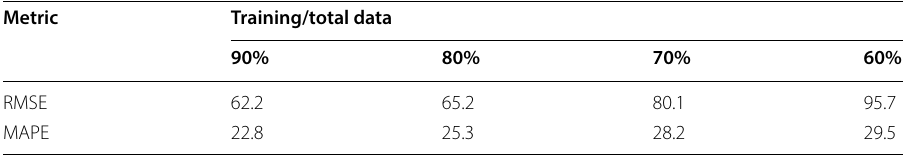
Table 7 Prediction model evaluation